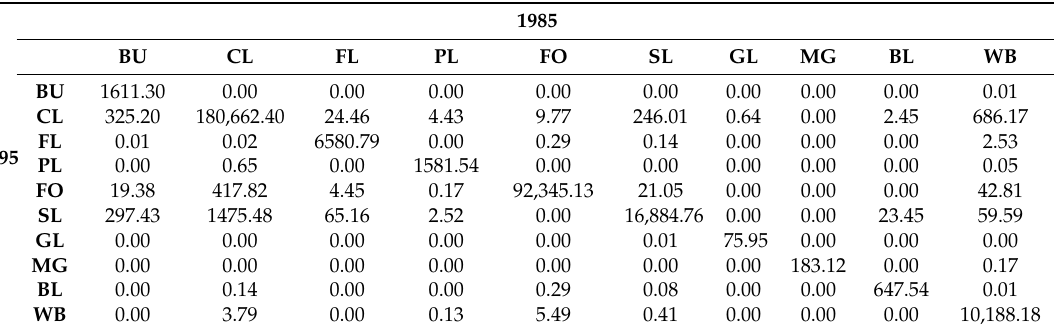
Table 3. Change detection matrix of 1985–1995.